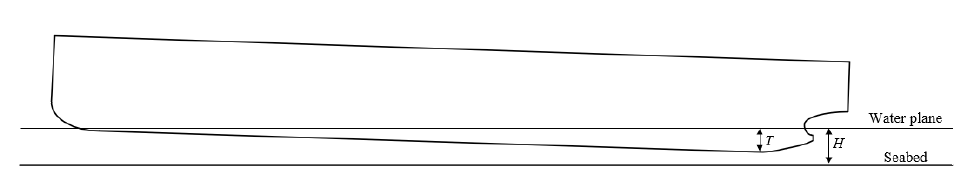
Figure 9. Arrangement for finite ‐ water ‐ depth condition.